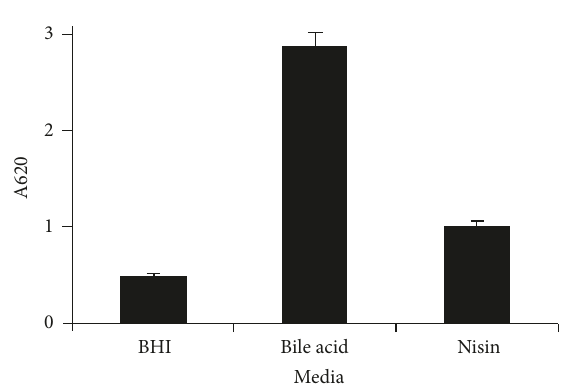
Figure 1: Production of enterotoxin in C. perfringens SM101 in BHI, with or without low concentrations of bile acids and nisin. The data represent the average of three independent